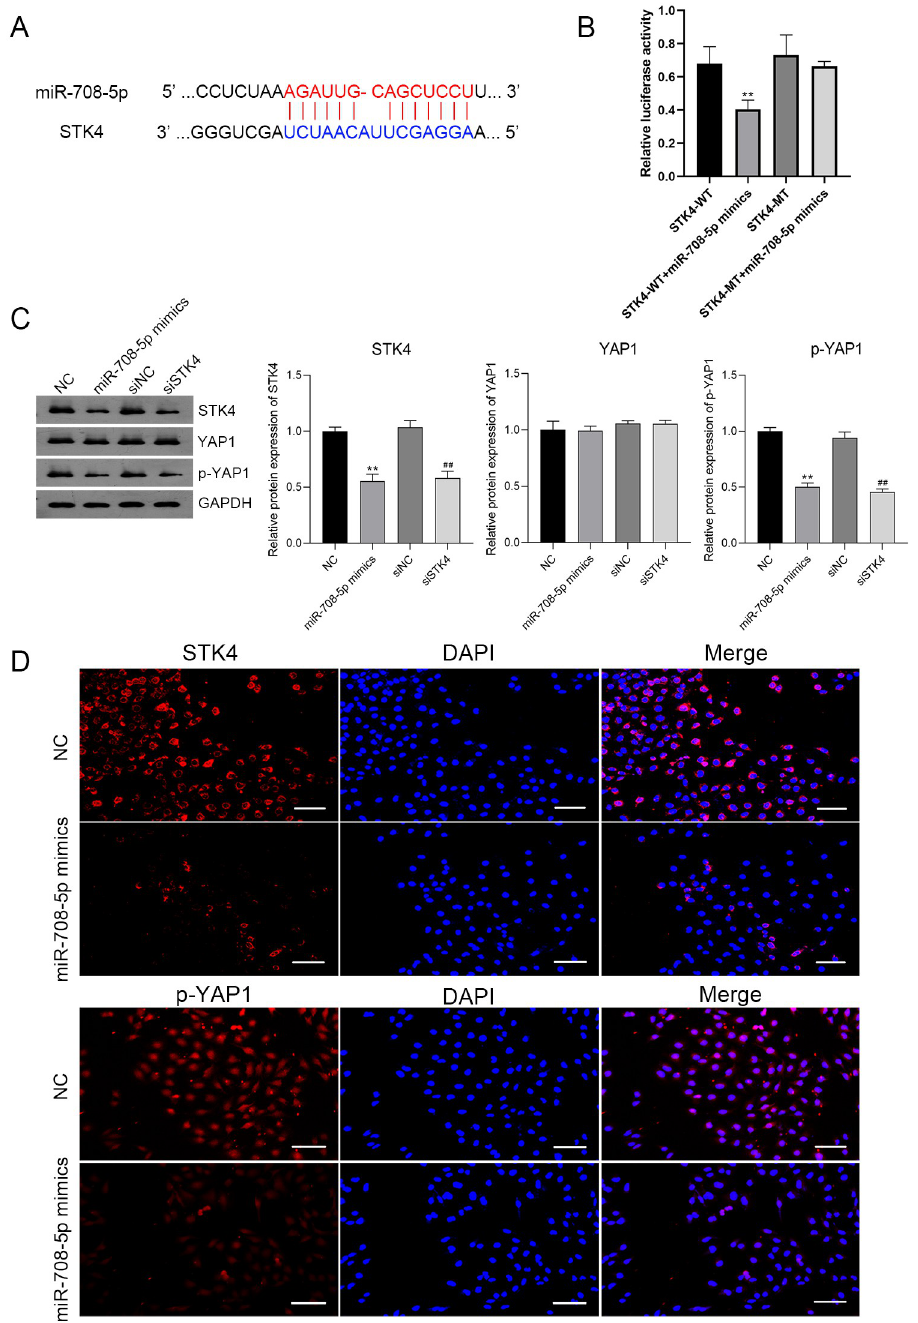
Fig 5. miR-708-5p inhibited STK4-mediated Hippo-YAP1 signaling pathway. (A) The targeting sequence of miR- 708-5p in the 3’UTR of STK4 was predicated using Starbase (http://starbase.sysu.edu.cn/index.php). (B) The interaction between miR-708-5p and STK4 was identified using dual-luciferase reporter assay. �� P < 0.01 compared with the STK4-WT group. (C) The relative protein expression levels of STK4, YAP1, and p-YAP1 in MDSCs overexpressed miR-708-5p (miR-708-5p mimics) and silenced with STK4 (siSTK4) were examined using Western blot. �� P < 0.01 compared with the NC and ## P < 0.01 compared with the siRNA-negative control (siNC). (D) The expression of STK4 and p-YAP1 in MDSCs overexpressed miR-708-5p was verified by immunofluorescence staining. Nuclear DAPI staining was presented in blue. Scale bar is 200 μ m.